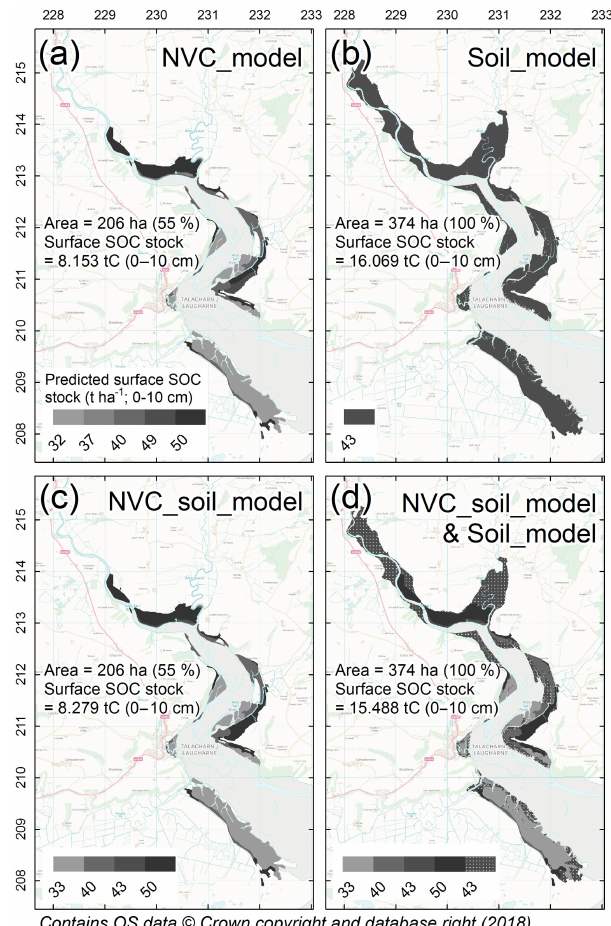
Figure 2. Predictions of surface SOC stock (tCha − 1 ; 0–10cm) for salt marshes at Laugharne in south Wales. SOC stock was pre- dicted by (a) NVC class only (NVC_model), (b) simplified soil type only (Soil_model), (c) NVC and simplified soil type combined (NVC_soil_model), and (d) NVC_soil_model (used where NVC communities were mapped), combined with Soil_model (remain- ing salt-marsh area where NVC community information was not available). Inserted into maps are estimates of the total amount of surface SOC (tC) (0–10cm) for the area of the salt marsh (%) for which we had the necessary information to make predictions, with panel (d) illustrating best practice. Laugharne marsh included NVC communities for which the study did not have predictive surface SOC stock-to-NVC relationships; hence, panels (a) and (c) include areas without SOC predictions (white colour) and the percentage of the marsh area for which SOC predictions were made is <